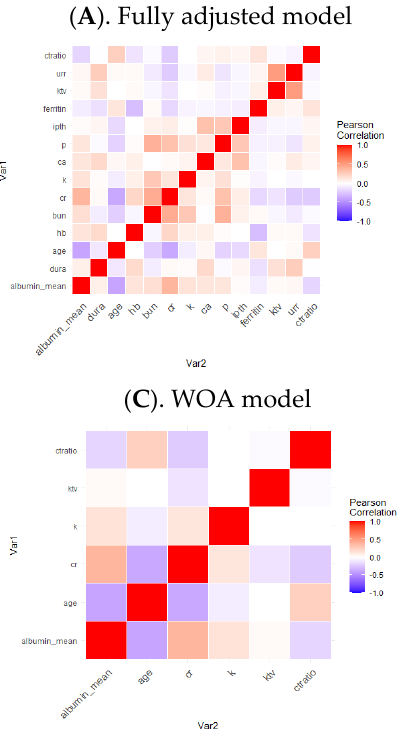
Figure 2. Comparison of correlation heatmaps of clinical factors in fully adjusted, stepwise, and WOFS models. The blocks represent the correlation levels between clinical factors. The blue and red colors are the positive and negative correlation, respectively.